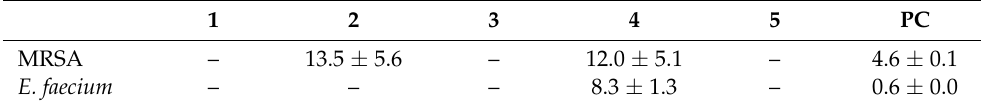
Table 3. Antibacterial effects of compounds 1 – 5 . The IC 50 values are in µ M. Positive controls (PC) were chloramphenicol (MRSA) and ampicillin ( E. faecium ),